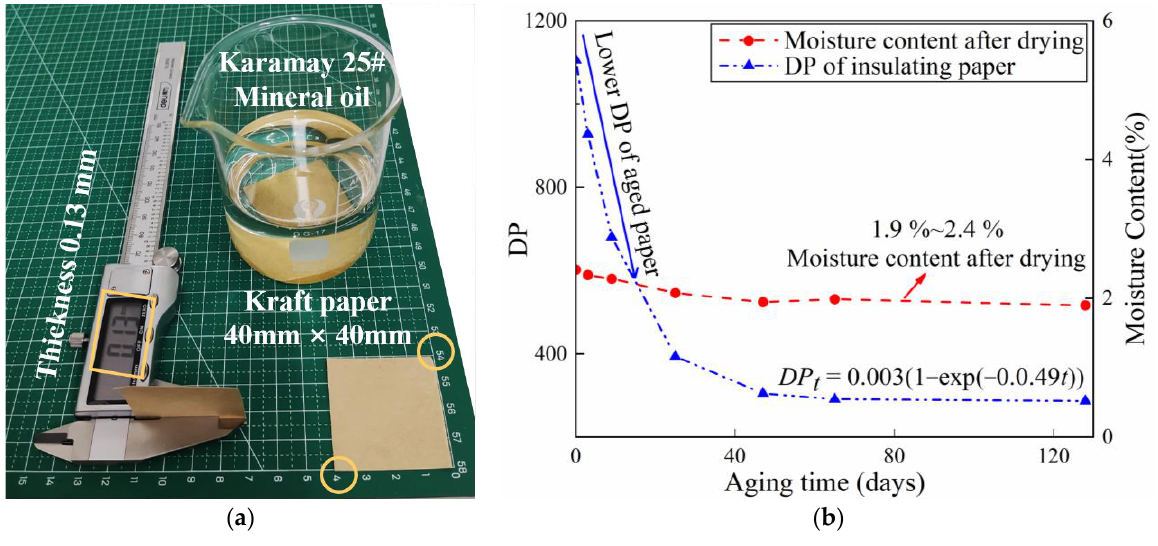
Figure 1. ( a ) The oil-paper insulation materials. ( b ) DP and moisture content of the insulating